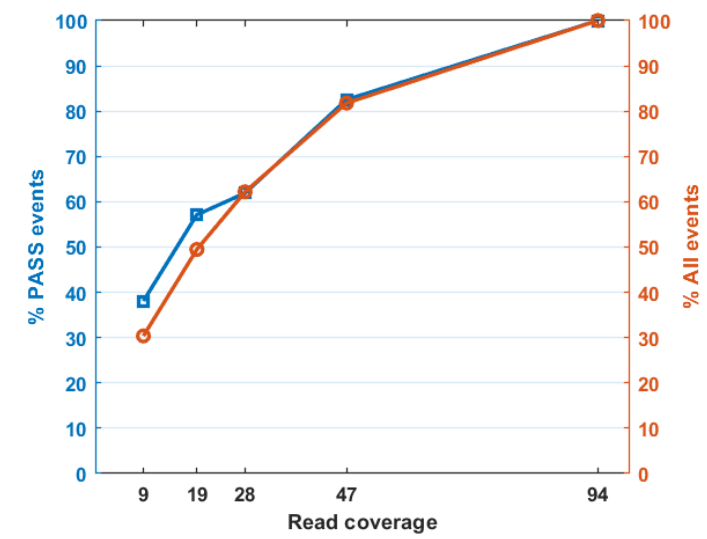
Figure 3. Percent of detected TIP events with respect to read coverage in the input alignment file. Orange circles depict all reported events while blue triangles represent PASS events.